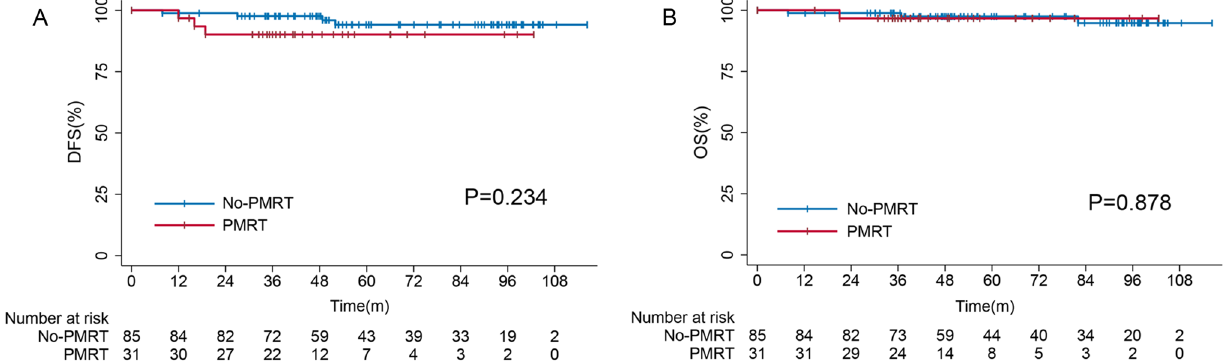
Fig. 2 Kaplan–Meier survival curve according to delivery of PMRT. A Disease-Free survival. B Overall survival. Legends: A No significant dif- ferences in DFS were shown between the PMRT group and no-PMRT group (5-year DFS: 90.2% vs 93.7%, p = 0.234). B No significant differ- ences in OS were shown between the PMRT group and no-PMRT group (5-year OS: 96.7% vs 97.3%, p =